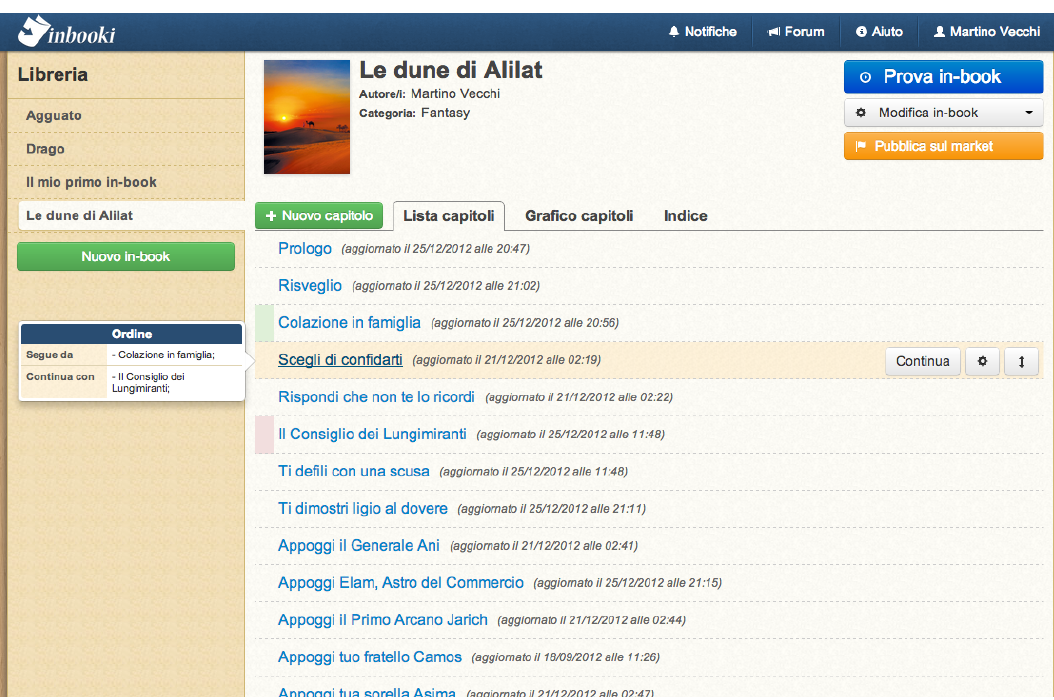
Figure 4. Inbooki